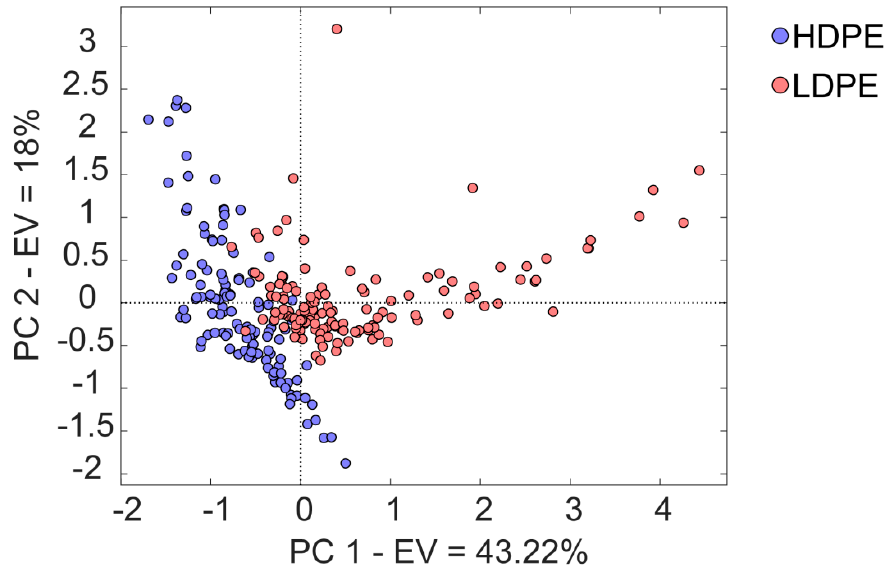
Figure 5. Results of principal components analysis carried out with spectral data of polyethylene (PE) class polymers. Score plot of the first two components is shown.